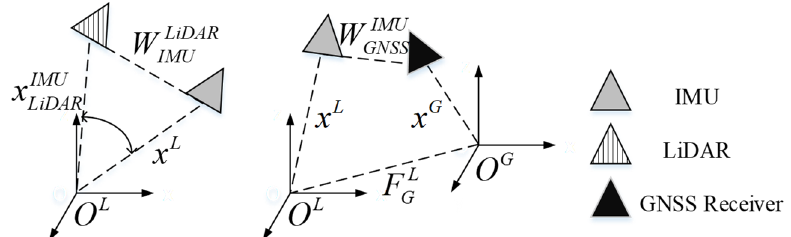
Figure 5. Schematic diagram of the spatial unification of multi-sensor poses. The spatial association of the poses of LiDAR and IMU in the local coordinate system is on the left, and the spatial association of the poses of IMU and GNSS receivers in the global coordinate system is on the right.